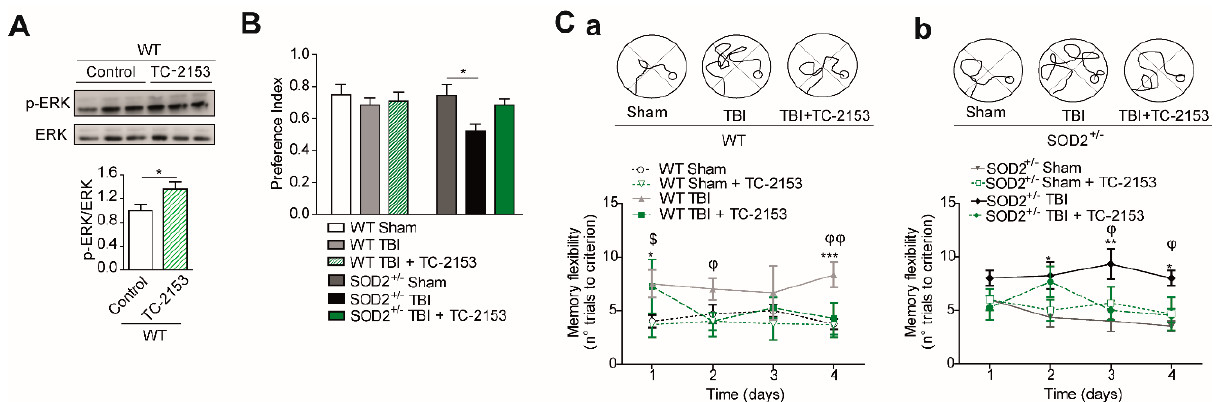
Figure 7. Pharmacological inhibition of STEP 61 restores the cognitive impairment induces by TBI in WT and SOD2 +/ − mice. ( A ). Pharmacological inhibition of STEP 61 by intraperitoneal injection of TC-2153 10 µg/Kg measured by p-ERK level in the western blot analysis. ( B ). NOR test of WT and SOD2 +/ − under TBI condition and treated with TC-2153. ( C ). Spatial memory of WT ( Ca ) and SOD2 +/ − ( Cb ) mice after TBI and treated with TC-2153 was evaluated by the memory flexibility test. Three animals were used per experimental group for western blot analysis, and animals were used per experimental group for NOR and MF tests. Data are means ± S.E. Statistically, significant differences were calculated by one-way or two-way ANOVA, followed by post hoc Bonferroni’s test. Symbols indicate the statistical significance of the observed differences (Figure 7A,B: * p < 0.05; Figure 7Ca: * p < 0.05, *** p < 0.001 between WT Sham and WT TBI, $ p < 0.01 between WT Sham and WT TBI + TC-2153, ϕ p < 0.05, ϕϕ p < 0.01 between WT TBI and WT TBI + TC-2153; Figure 7Cb, * p < 0.05, ** p < 0.01 between SOD2 +/ − Sham and SOD2 +/ − TBI; ϕ p < 0.05 between SOD2 +/ − TBI and SOD2 +/ − TBI +